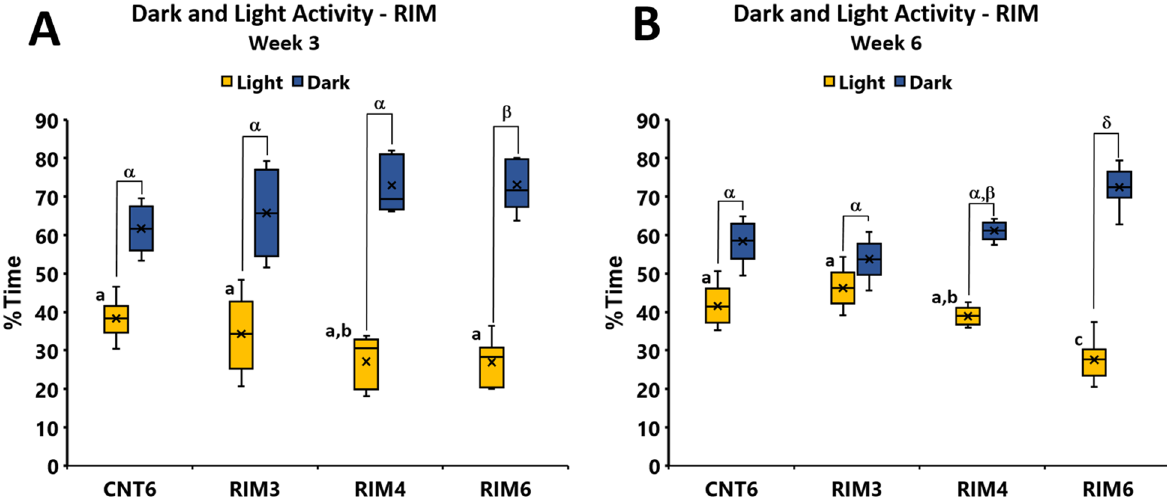
Figure 5. Dark and light behavioral assessment at 3 and 6 weeks postinduction in mice subjected to reserpine- induced myalgia. At ( A ) three and ( B ) six weeks postinduction, RIM6 animals showed a significant decrease in time spent in the light zone compared with CNT6 animals. Additionally, the difference between the time spent in zones was significantly increased in the RIM6 group at both three and six weeks postinduction. Data are expressed as the median ± IQR, and the mean is also shown as a x. a–c: Groups not sharing a letter showed significant differences in time spent in the light zone, p < 0.05; α–β: Groups not sharing a letter showed significant differences in time spent in the light zone—time spent in the dark zone p <